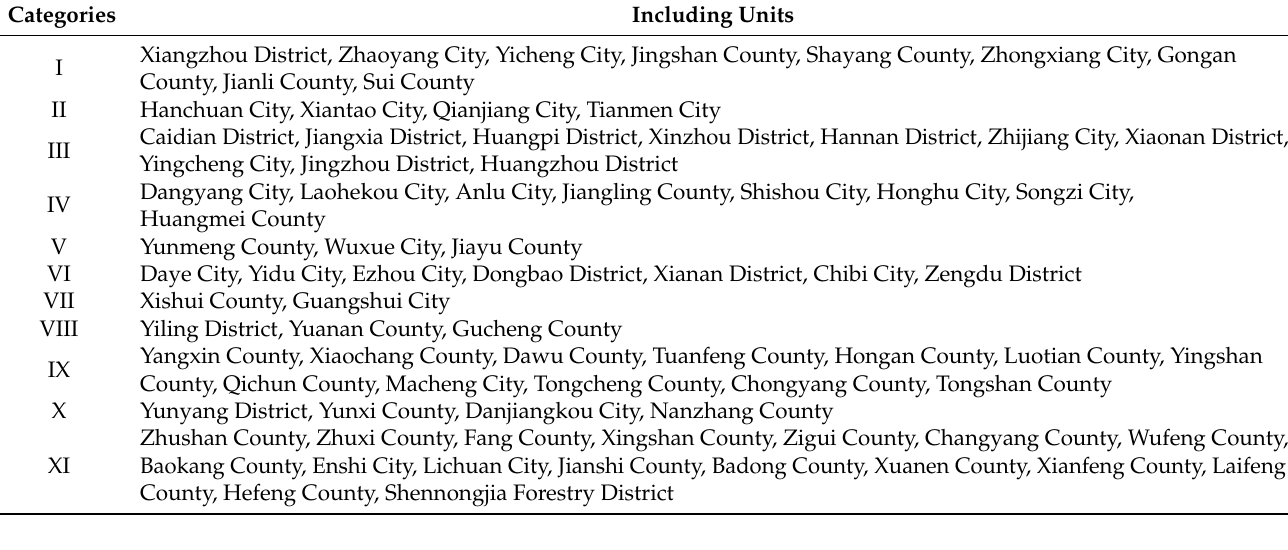
Table 2. Land consolidation zoning classification in Hubei province based on SOM.